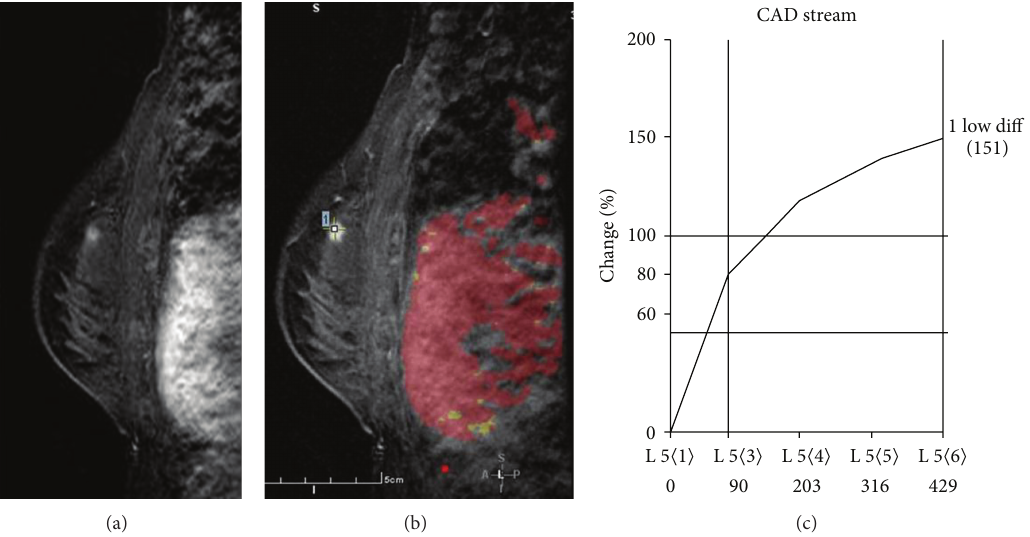
Figure 1: (a) A 6mm new enhancing focus in the upper inner breast with slightly spiculated margins. (b) CAD image demonstrates that there is not enough enhancement to meet “threshold” value. (c) Graphical evaluation of enhancement demonstrates progressive type kinetics.